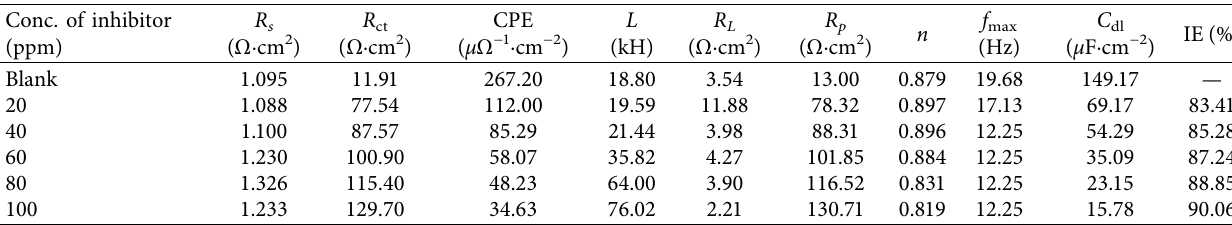
Table 2: Electrochemical impedance factors for mild steel with the concentration range of AMP from 0 to 100ppm in 1M HCl. Conc. of inhibitor